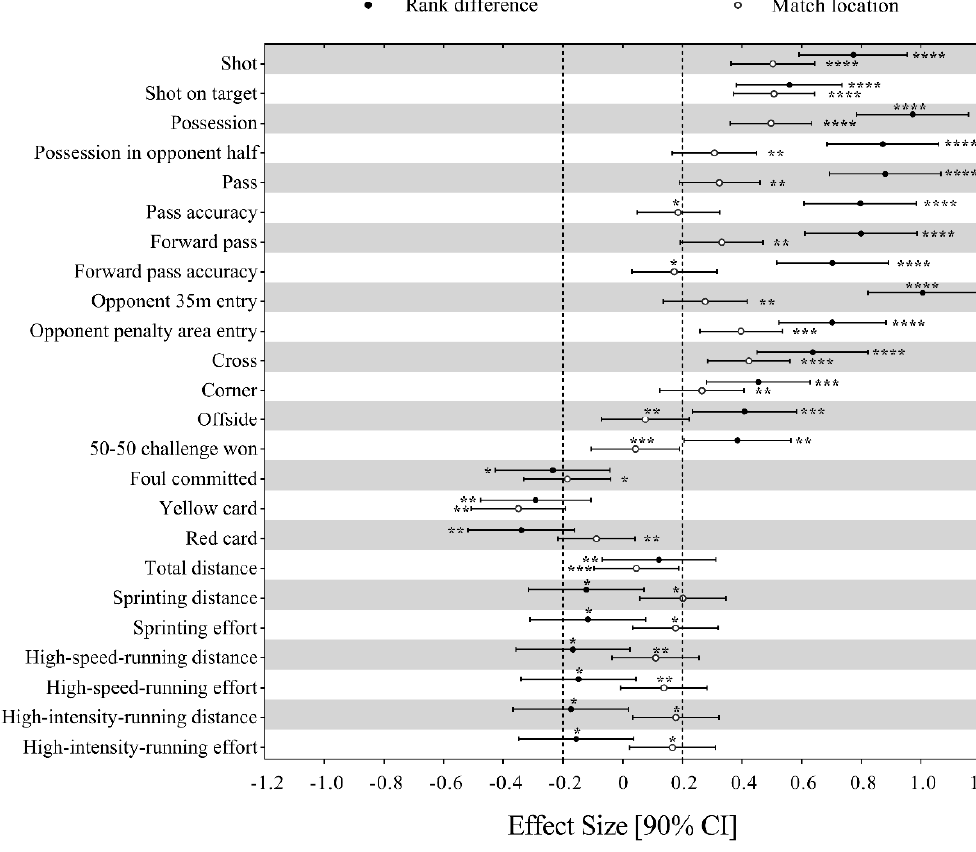
Figure 1. E ff ects of situational variables on The technical and physical performance of Chinese Soccer Figure 1. Effects of situational variables on the technical and physical performance of Chinese Soccer Super League (CSL) teams. E ff ects of team and opponent strength are shown as The e ff ect of an increase Super League (CSL) teams. Effects of team and opponent strength are shown as the effect of an of two standard deviations in The value of di ff erence in The log of ranks on The di ff erence of each increase of two standard deviations in the value of difference in the log of ranks on the difference of performance-related parameter. E ff ects of match location are shown as The e ff ect of playing at home each performance-related parameter. Effects of match location are shown as the effect of playing at vs. playing away on The di ff erence of each performance-related parameter. Bars are 90% confidence home vs. playing away on the difference of each performance-related parameter. Bars are 90% intervals. Dotted lines represent The smallest worthwhile di ff erence. Asterisks indicate The likelihood confidence intervals. Dotted lines represent the smallest worthwhile difference. Asterisks indicate the for The magnitude of The true e ff ect as follows: * possible; ** likely; *** very likely; **** most likely. likelihood for the magnitude of the true effect as follows: * possible; ** likely; *** very likely; **** most Asterisks located in The trivial region denote likelihood of trivial e ff likely. Asterisks located in the trivial region denote likelihood of trivial effects.